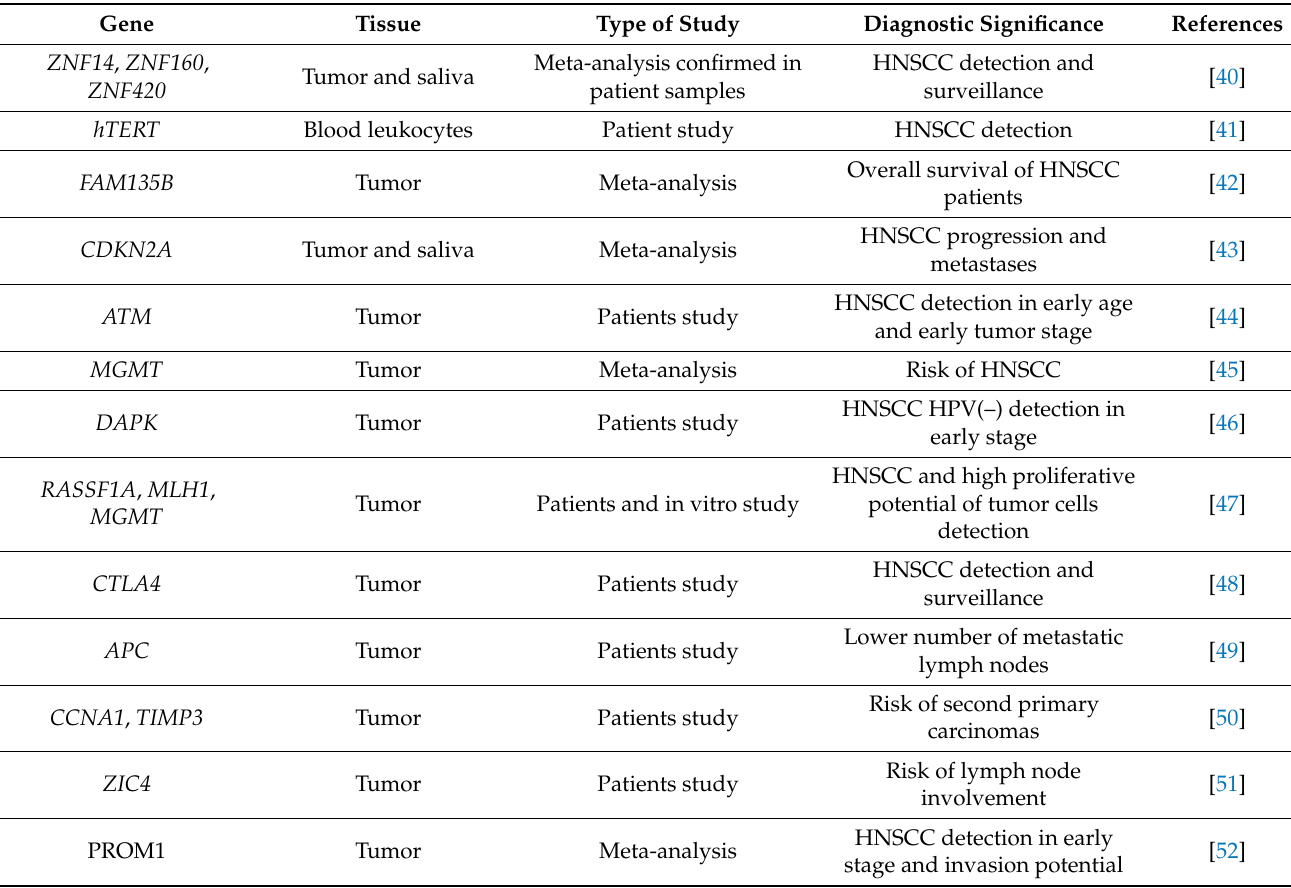
Table 1. Hypermethylated gene with diagnostic value identified in head and neck squamous carcinoma (HNSCC). Gene Tissue Type of Study Diagnostic